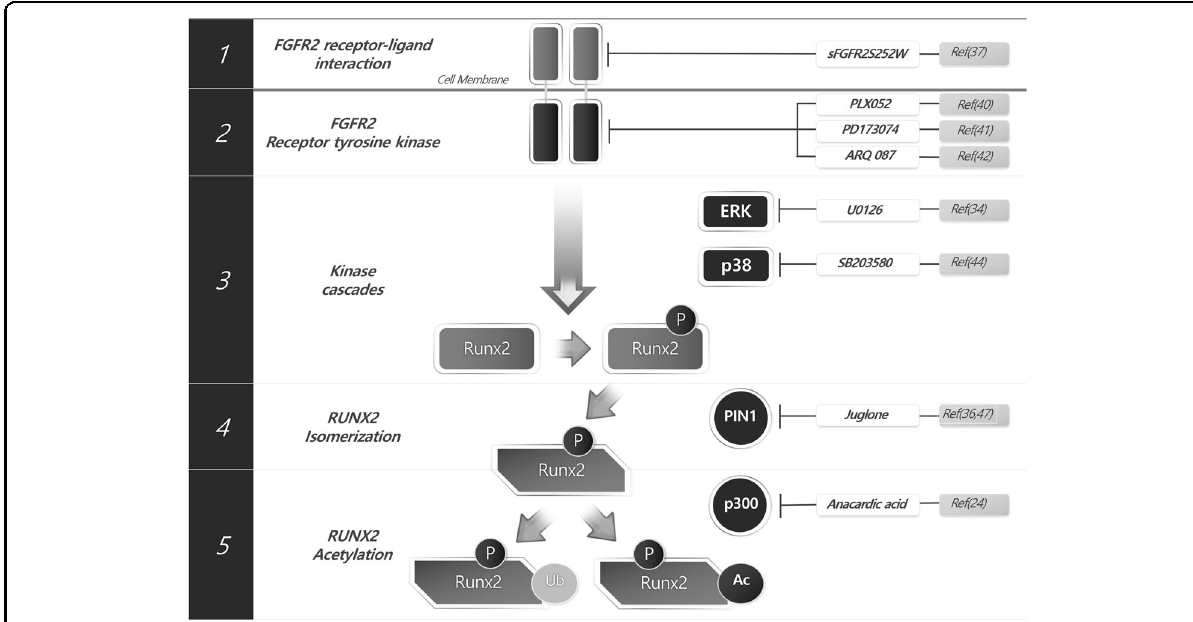
Fig. 2 Therapeutic intervention points targeting RUNX2 activity regulation for the treatment of craniosynostosis. The soluble FGFR2 decoy receptor sFGFR2S252W may sequester and inhibit FGF ligands from binding to cell surface receptors. The receptor tyrosine kinase inhibitors PLX052, PD173074 and ARQ087 may block ligand binding-induced signaling propagation to cytosolic mediators. The MEK1/2 inhibitor U0126 or p38 inhibitor SB203580 blocks cytosolic mediator or nuclear transcription factor phosphorylation. The PIN1 inhibitors juglone and DTM block cis-trans structural modi fi cation of phosphorylated proteins. The HAT inhibitor anacardic acid blocks protein stabilization and activation by